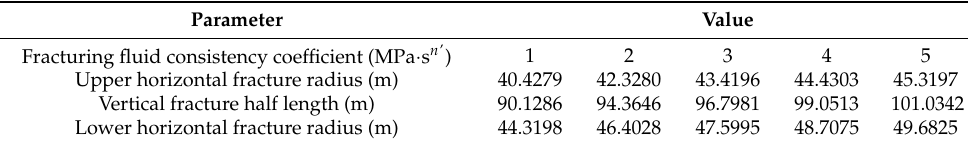
Table 5. Fracture geometry changes with a fracturing fluid consistency